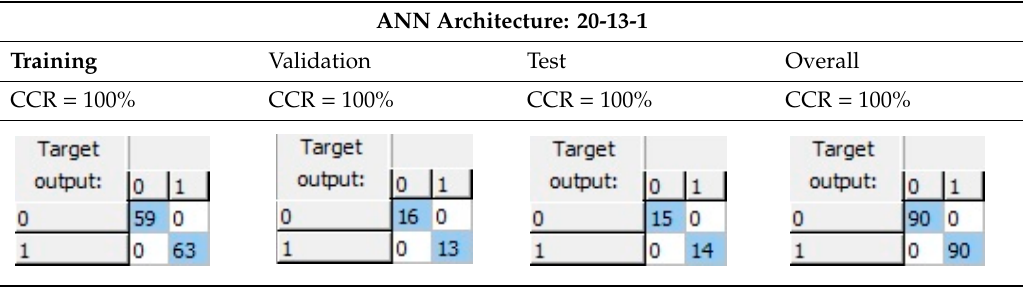
Table 2. Correct classification rates (CCRs) and confusion matrices of the obtained artificial neural network (ANN) model for freeze-damage detection in lemons by